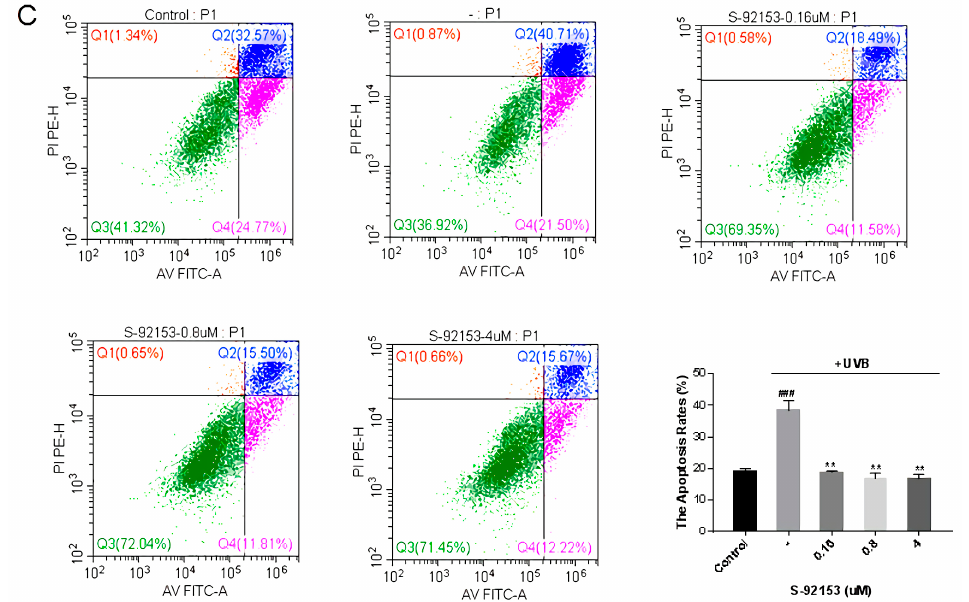
Figure 11. Inhibition of ( A ) CBD, ( B ) S ‐ 88745 and ( C ) S ‐ 92153 on UV ‐ induced apoptosis in HFF ‐ 1. The control group was not stimulated by UV. The UV ‐ treated group ( ‐ ) produced a lot of reactive oxygen species after UV stimulation. The experiments were repeated three times. Each bar illustrates the average ± standard deviation (SD) counted from three experiments. p < 0.05 was considered statistically significant. ** p < 0.01 compared to the UV − treated group; ### p < 0.001 compared to the control group.